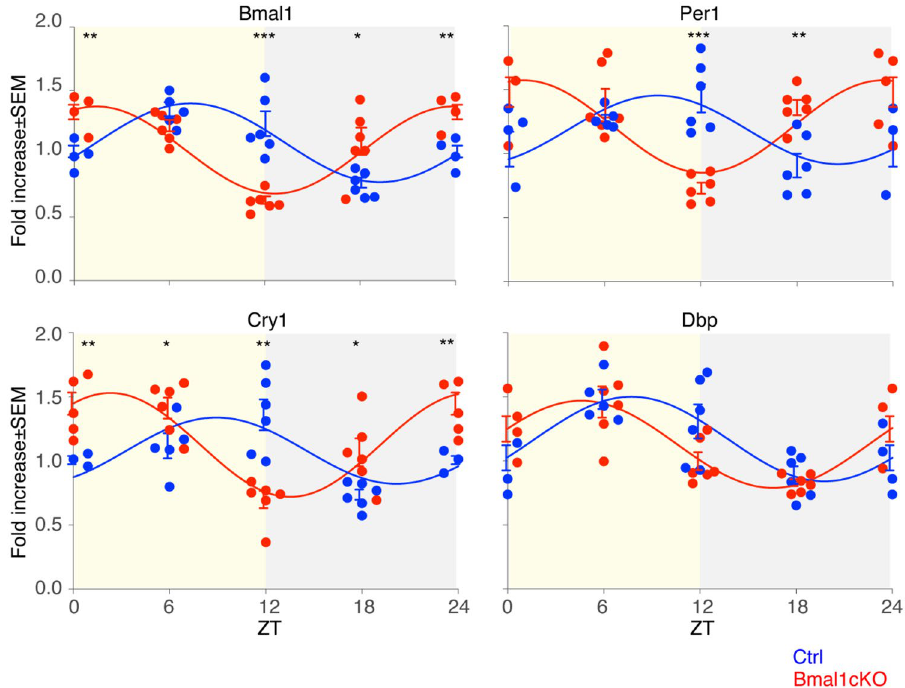
Figure 3. Altered rhythmic clock-genes expression in the retina upon GLAST + cells-specific Bmal1 deletion. Altered daily rhythms expression of some clock genes, i.e., Bmal1 , Cry1 , Per1, and Dbp, in the retina of Bmal1 cKO (red) compared to Ctrl (blue) in adult mice under 12:12 h LD cycles. The yellow background depicts the light phase (ZT 0–12), and the gray represents the dark phase (ZT 12–24). Samples were harvested at four equally distributed time points during the day, and ZT24 time points are the ZT0 ones shown again. Each curve depicts the best fitting (P < 0.05) between a cosine fitting with a period of 24 h or linear regression. Mean ± SEM of 4–6 animals per group at each time point, performed in triplicates (n = 4–6 per strain, Multiple t-tests, *P < 0.05, **P < 0.01, and ***P < 0.001 vs. Ctrl) are